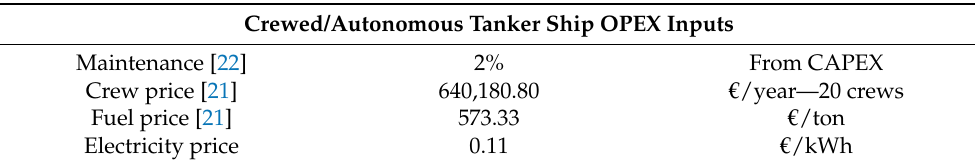
Table 15. Crewed/autonomous tanker ship OPEX inputs in Table